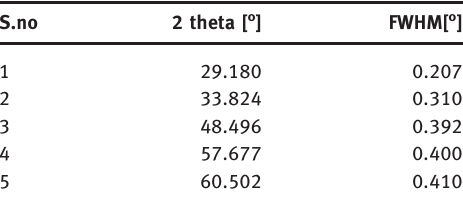
Table 5: FWHM values corresponding to the peak positions.